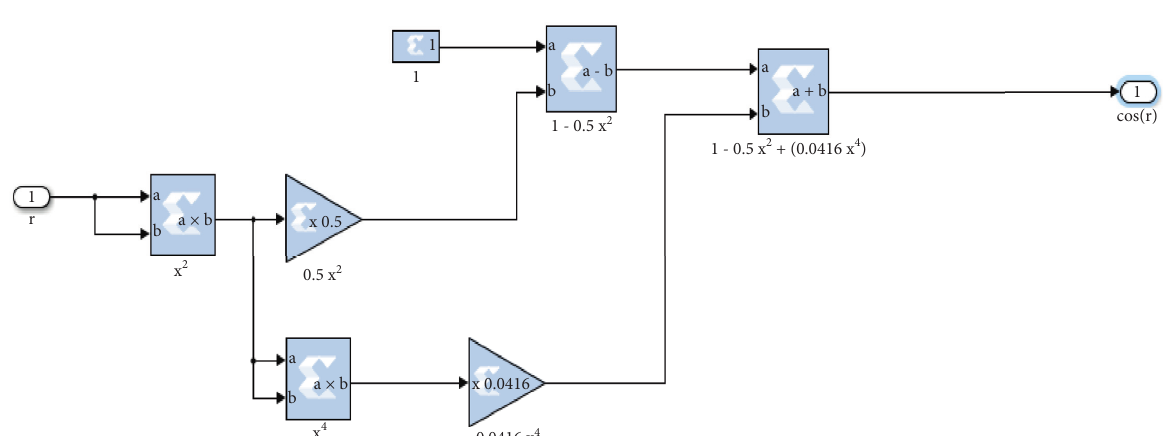
Figure 8: Taylor series of cosine function implemented using (XSG) Xilinx system generator toolbox. It is discretized implementation of cosine function based on equation